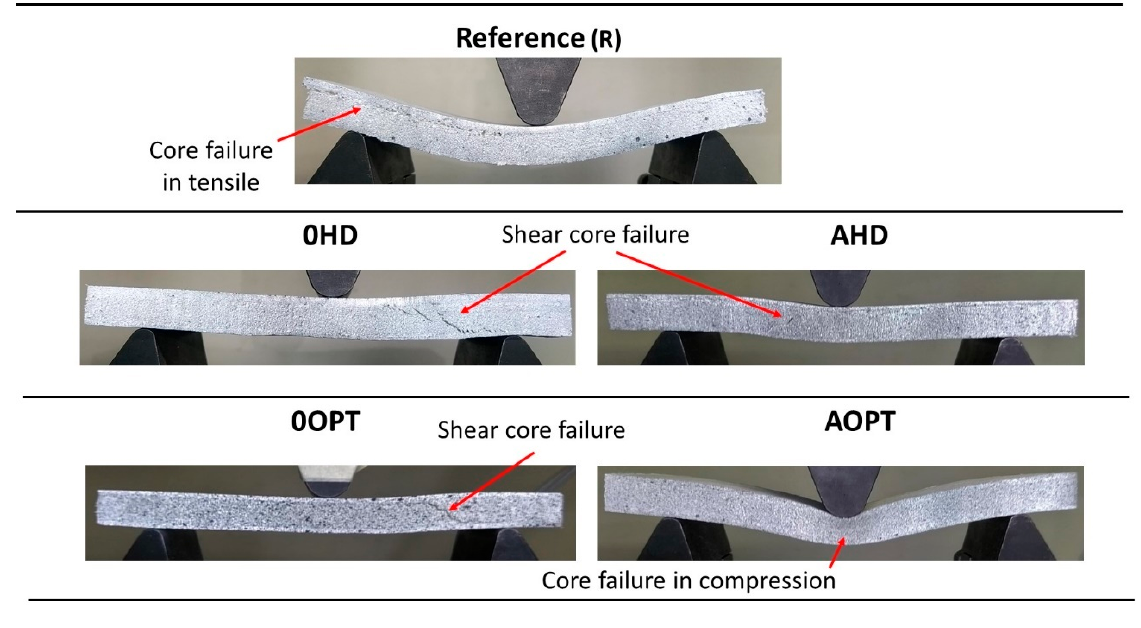
Figure 7. Sandwich panels’ failure patterns.